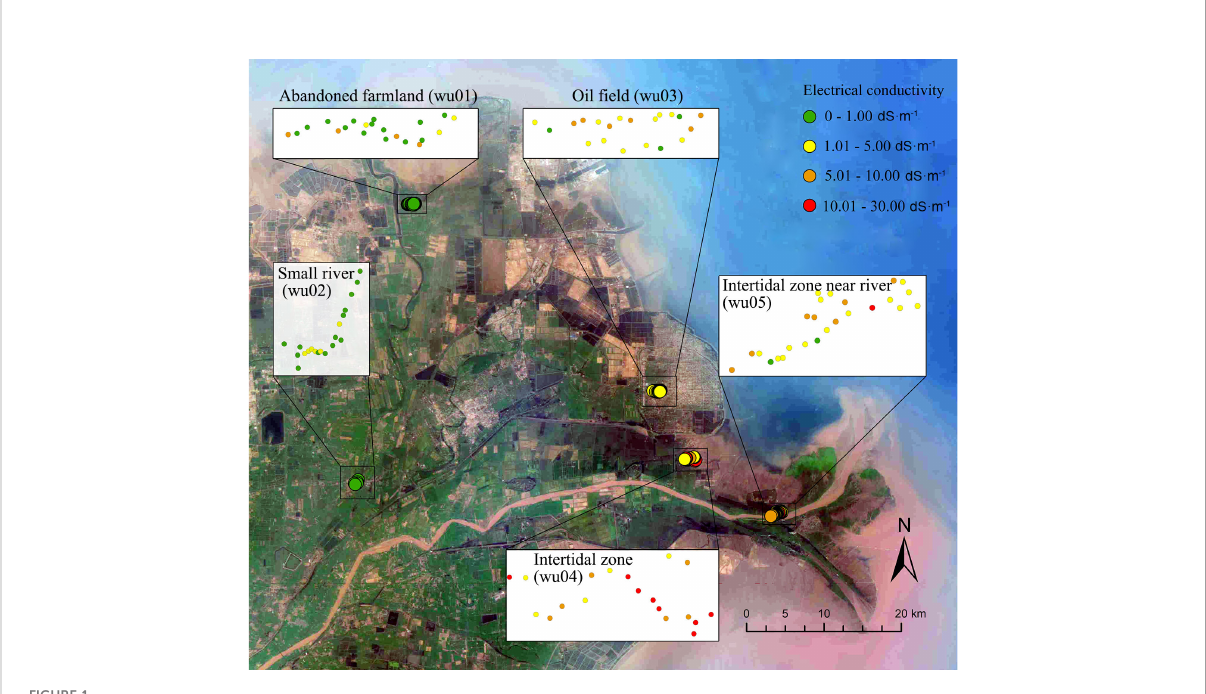
FIGURE 1 Map of Phragmites australis sites in Yellow River